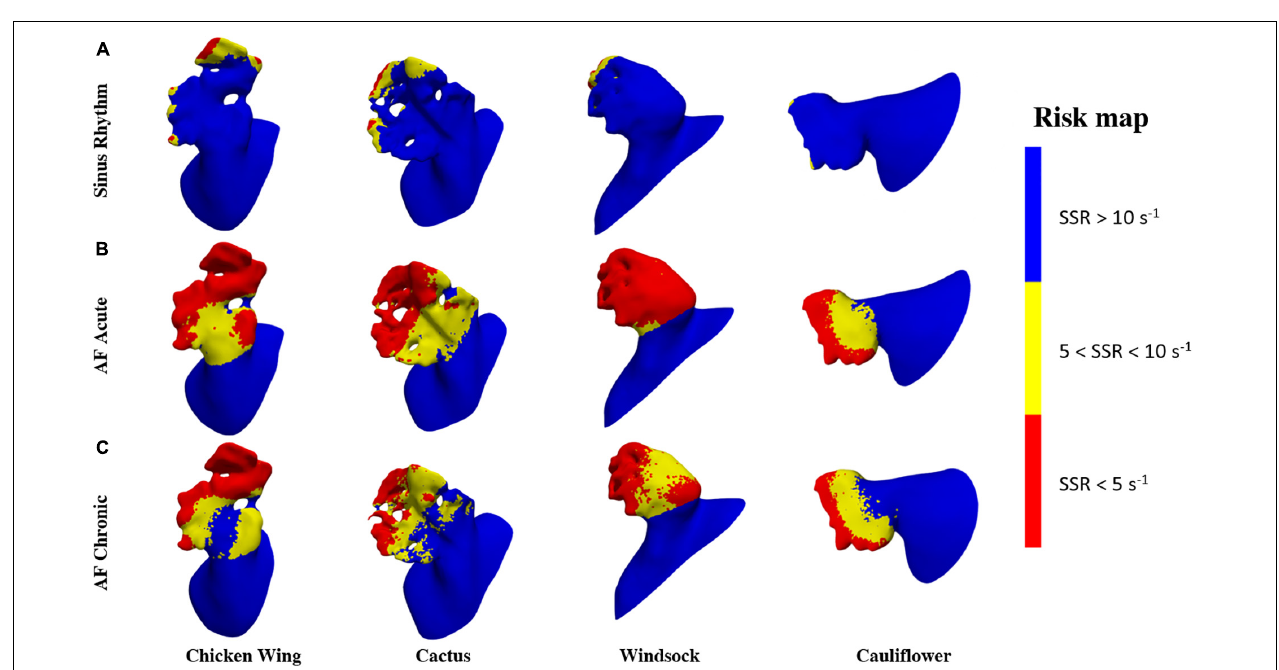
FIGURE 7 | Risk area maps in (A) sinus rhythm, (B) AF acute, and (C) AF chronic.